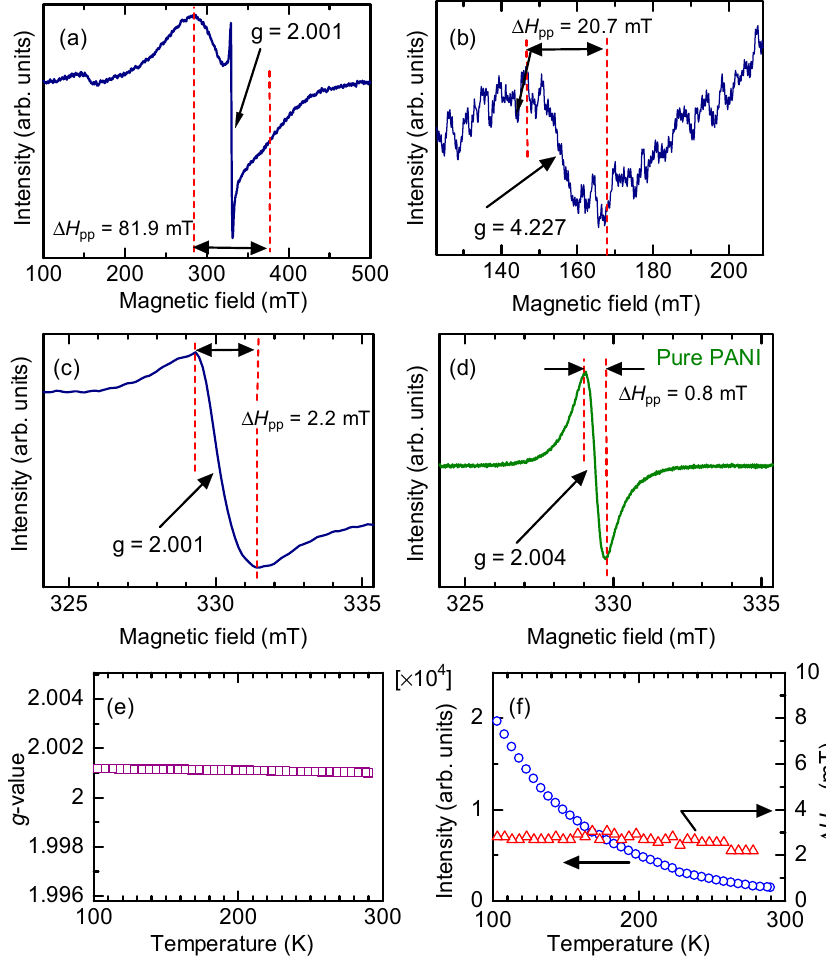
Figure 3. ( a ) Electron spin resonance (ESR) of IG–PANI at 100–500 mT range. ( b ) Half-field resonance. ( c ) ESR signal at around g = 2 as the center-field resonance. ( d ) ESR signal of pure PANI. ( e ) g-values vs. temperature. ( f ) Peak-to-peak peak line width ( Δ H pp ) of IG–PANI as a function of temperature.